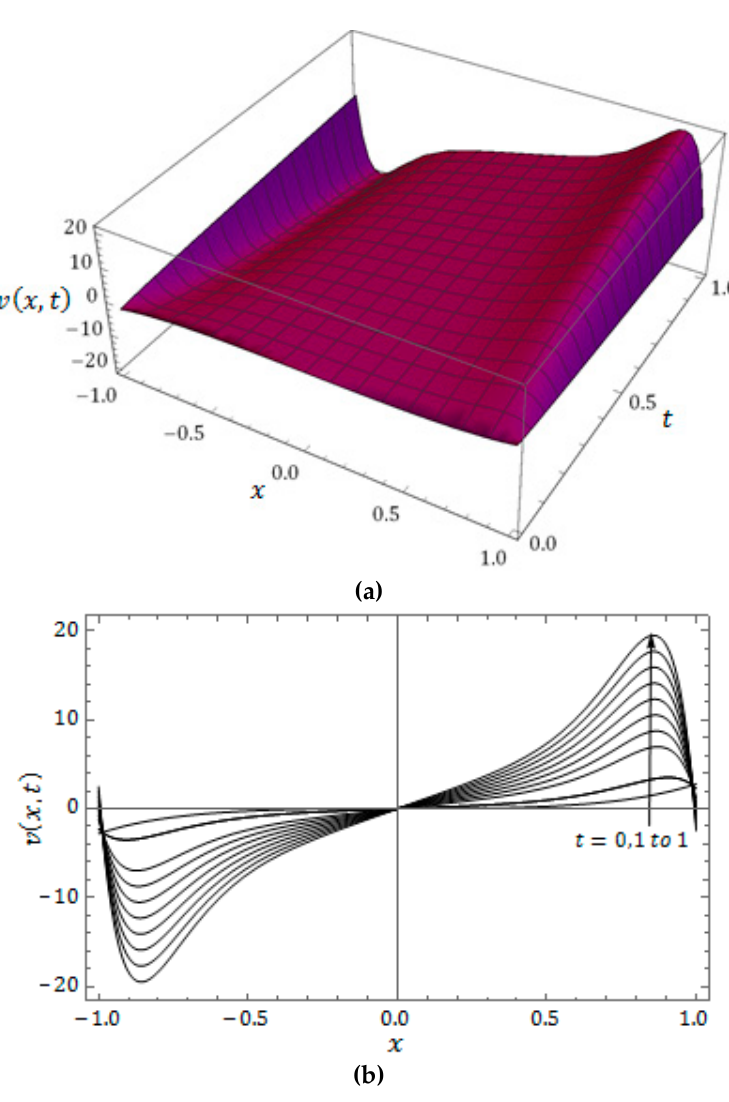
Figure 6. ( a ) Surface of q -HATM solution. ( b ) Nature of obtained solution at different times ( t is Figure 6 . (a) Surface of 𝑞 -HATM solution. (b) Nature of obtained solution at different times (𝑡 is from 0.1 to 1 ) for case ( iii ) at (cid:125) = − 1, n = 1, and µ = 1. Mathematics 2019 , 7 , x FOR PEER REVIEW from 0.1 𝑡𝑜 1) for case (𝑖𝑖𝑖) at ℏ = −1,𝑛 = 1 , and 𝜇 = 1.